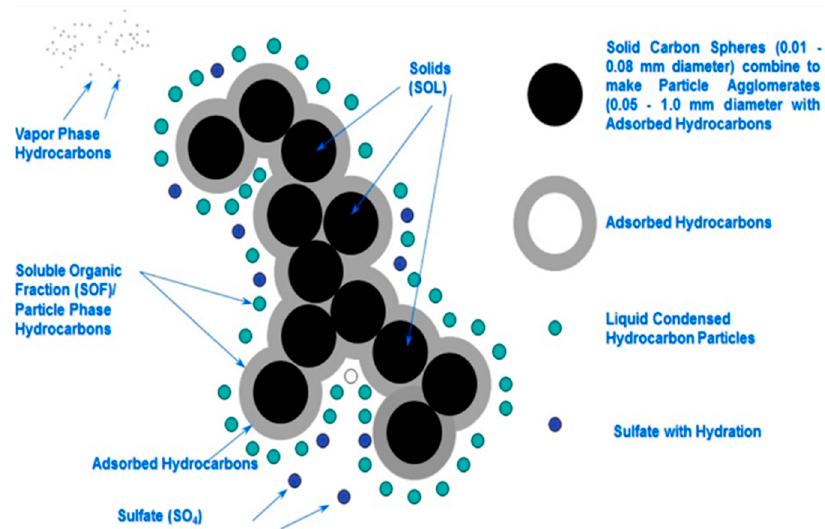
Figure 1. The specific composition of PM [33].